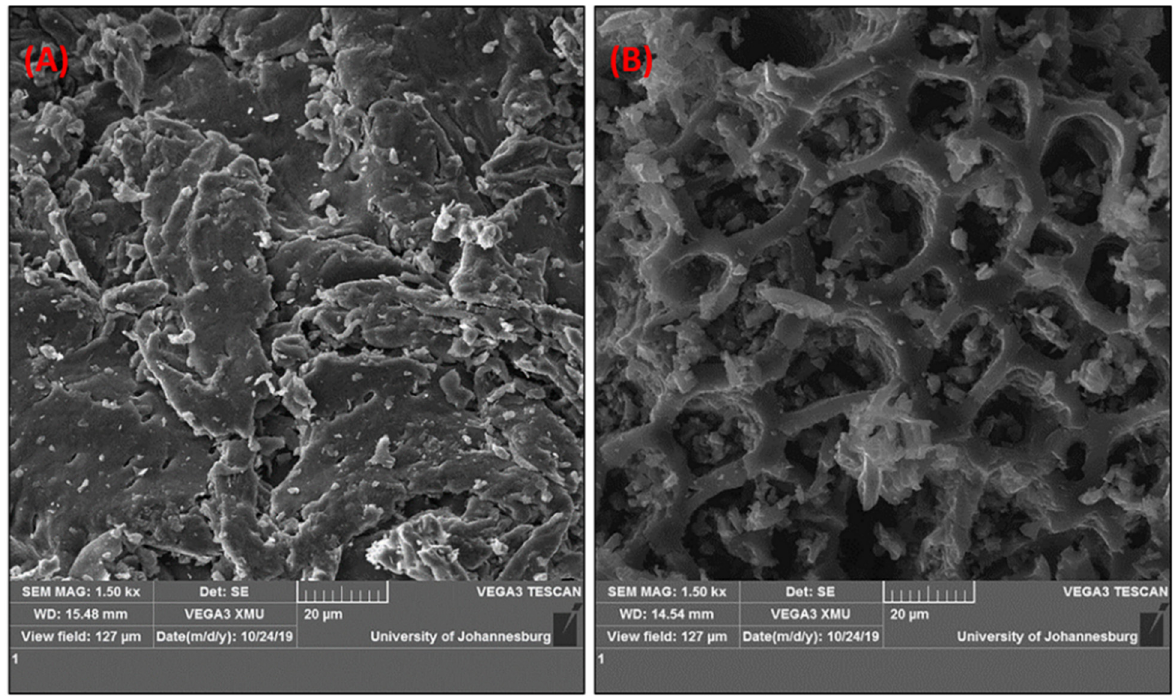
Figure 1. SEM micrographs of corn cob ( A ) and biochar ( B ).